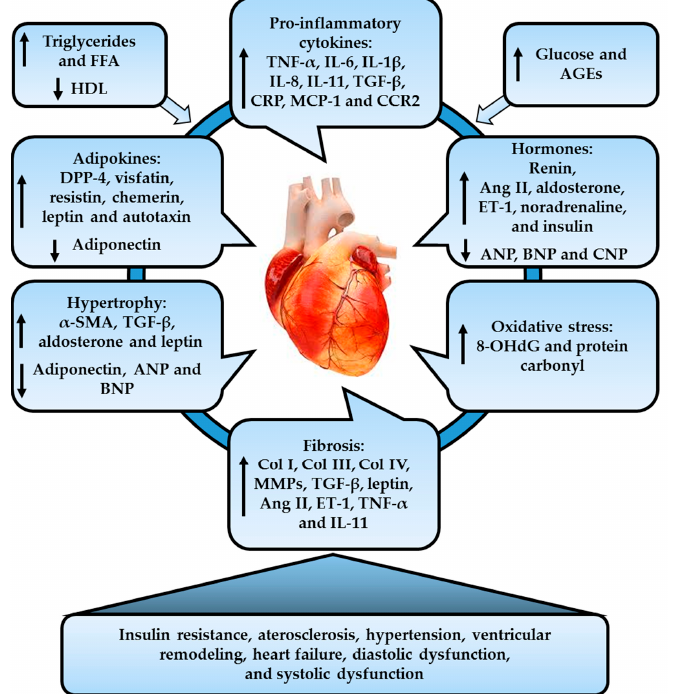
Figure 1. Pathophysiology involved in cardiovascular disease (CVD). Obesity ‐ related cardiac tis ‐ sue injury induces dysregulation in the expression of pro ‐ inflammatory cytokines, adipokines, and hormones, leading to oxidative stress, inflammation, systemic insulin resistance, atherosclerosis, as well as cardiac fibrosis and hypertrophy, and ultimately cardiac dysfunction. FFA: free fatty acids; HDL: high ‐ density lipoprotein; CRP: higher C ‐ reactive protein; MCP ‐ 1: monocyte chemotac ‐ tic protein 1; CCR2: chemokine re ‐ ceptor 2; AGEs: advanced glycation end products; DPP ‐ 4: di ‐ peptidyl peptidase 4; ET ‐ 1: endo ‐ thelin ‐ 1; OHdG: 8 ‐ hydroxy ‐ 2 ‐ deoxyguanosine; MMPs: matrix metalloproteinase; ANP: atrial natriuretic peptide; BNP: B ‐ type natriuretic peptide; CNP: C ‐ type natriuretic